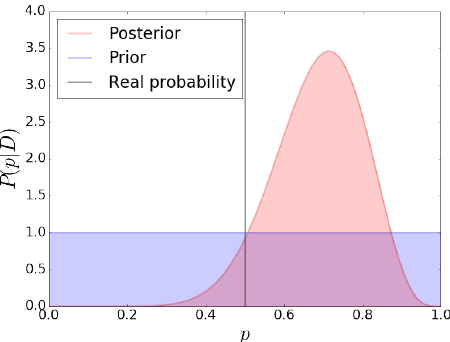
D ) (red). The vertical black line |